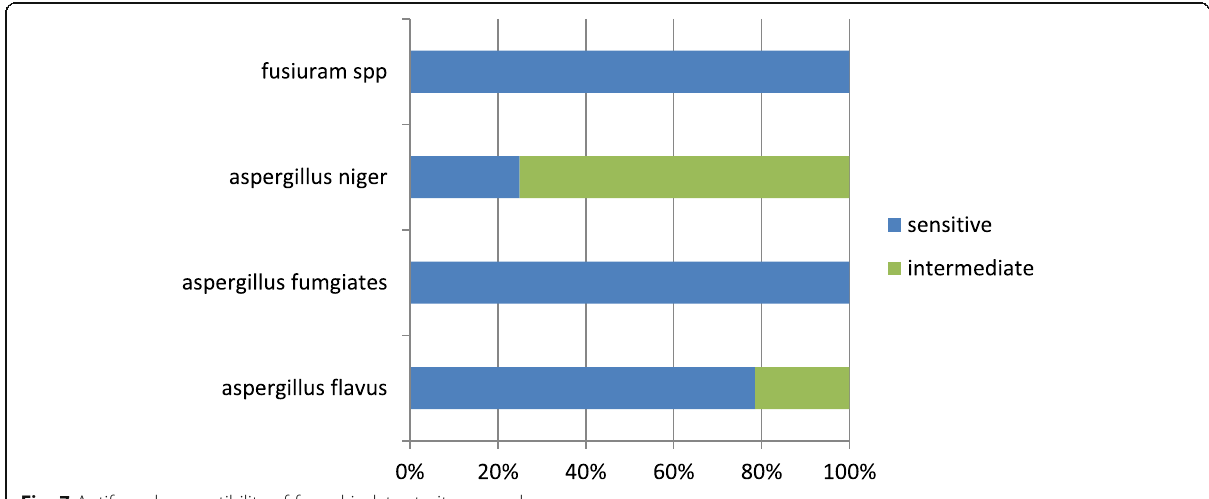
Fig. 7 Antifungal susceptibility of fungal isolates to